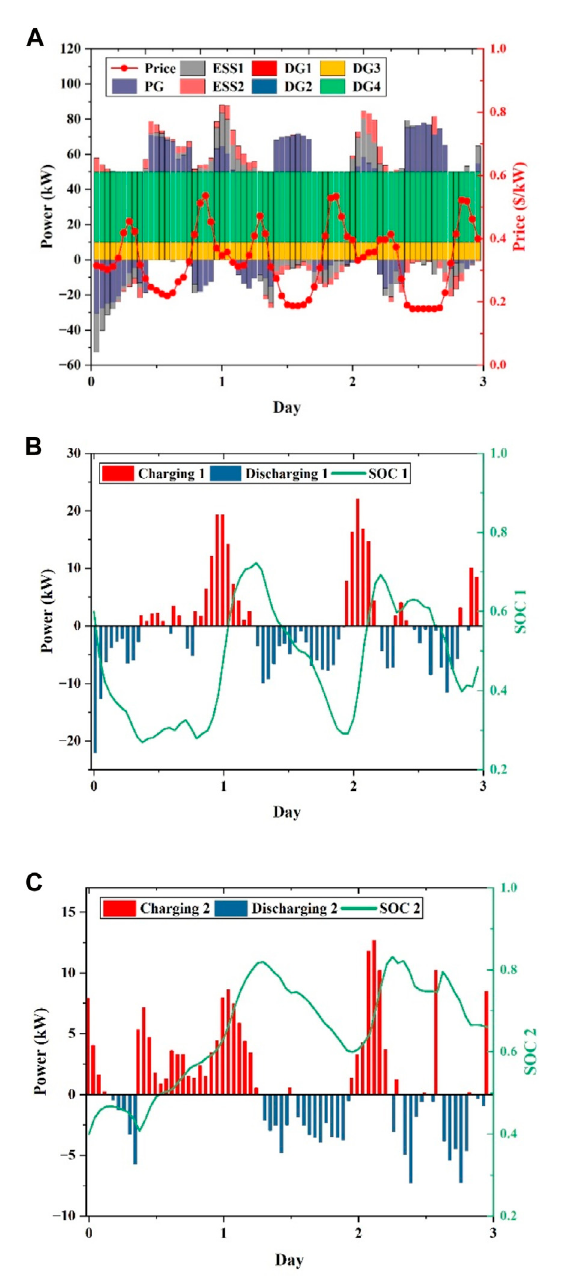
FIGURE 16 Scheduling results of the complex MG over three consecutive days in the test set: (A) Generation schedules of DGs, ESSs, and the main grid; (B) scheduled charging or discharging power and SOC of ESS1;and (C) scheduledchargingordischargingpowerandSOC of ESS